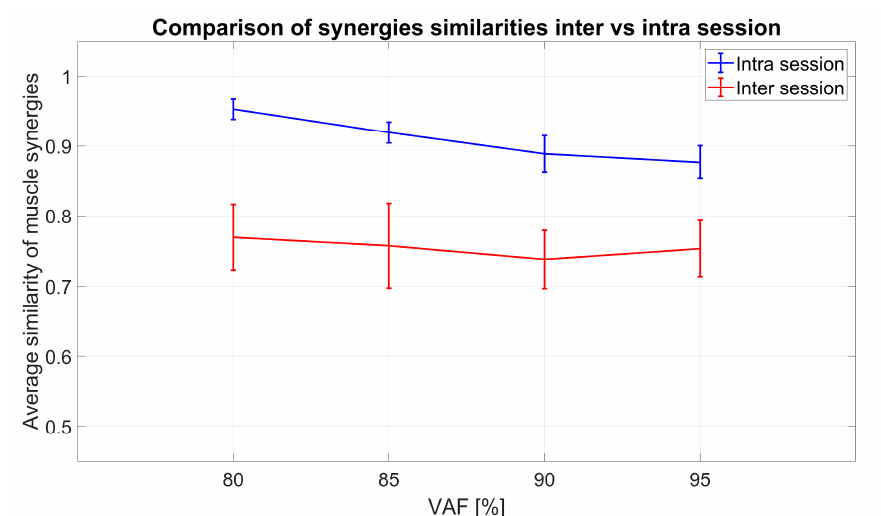
Figure 14. Inter-session (red graphs) and intra-session (blue graphs) similarity values for several VAF thresholds, summarized for all 10 subjects: Inter-session represents similarities between sessions of the same subject, while intra-session similarity between synergies is achieved comparing several sub-selections of movements (from the same session) across 5 sessions for each subject.